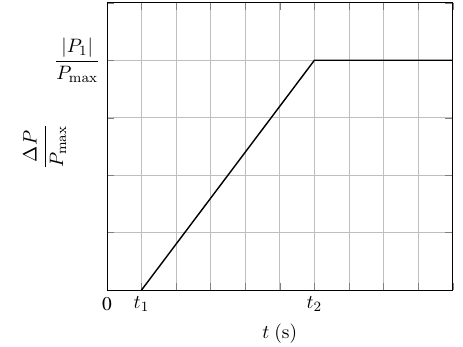
Figure 3. Constant DC voltage